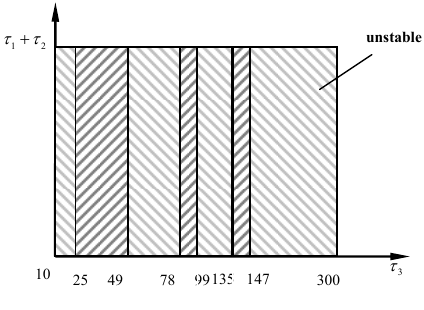
Fig. 5. Stable and unstable zones of system (2) at τ = 1 , τ = 13 and τ 1 2